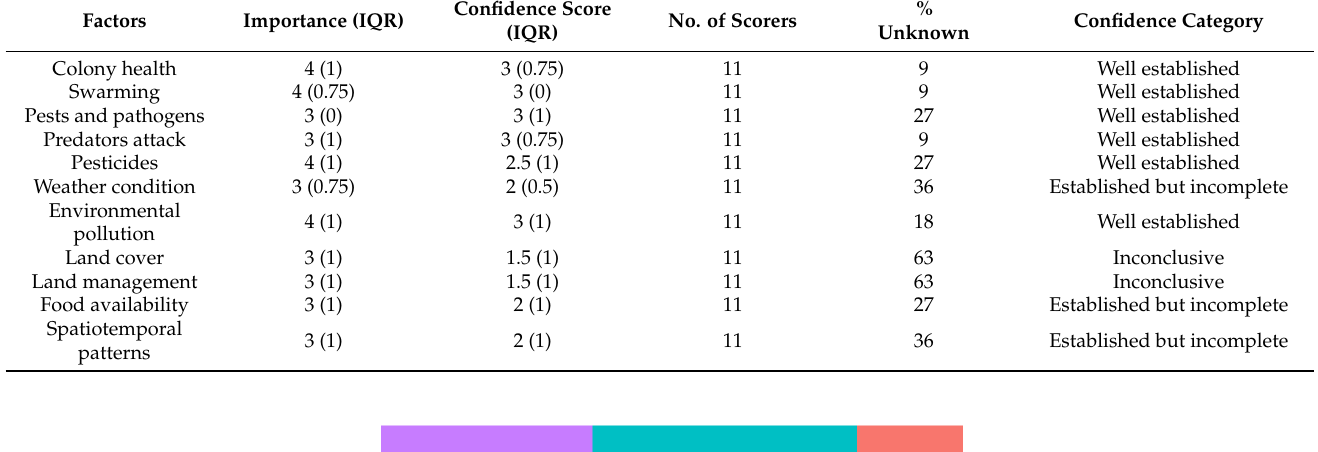
Table 3. Final factor scores summarized: The median scores for importance (1–5) as well as confidence (1–3) are exhibited here according to the described scale. Moreover, interquartile ranges (IQRs), for importance and confidence, are presented in the brackets. The total number of scorers plus “% unknown” scoring is displayed, along with the confidence category for each factor.